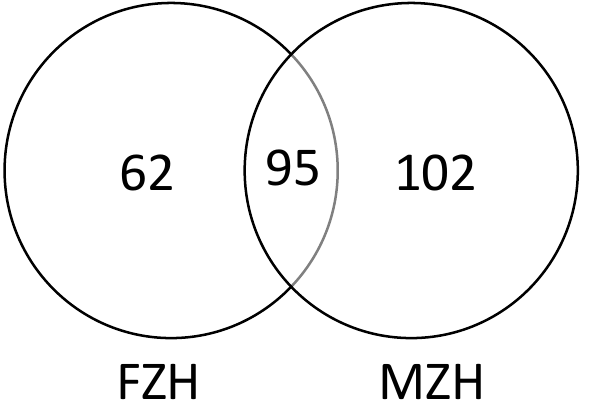
Figure 1. Venn diagram of metabolites found in the mycelia (MZH) and the fermentation broth (FZH) of Epichloë sinensis when cultivated in liquid